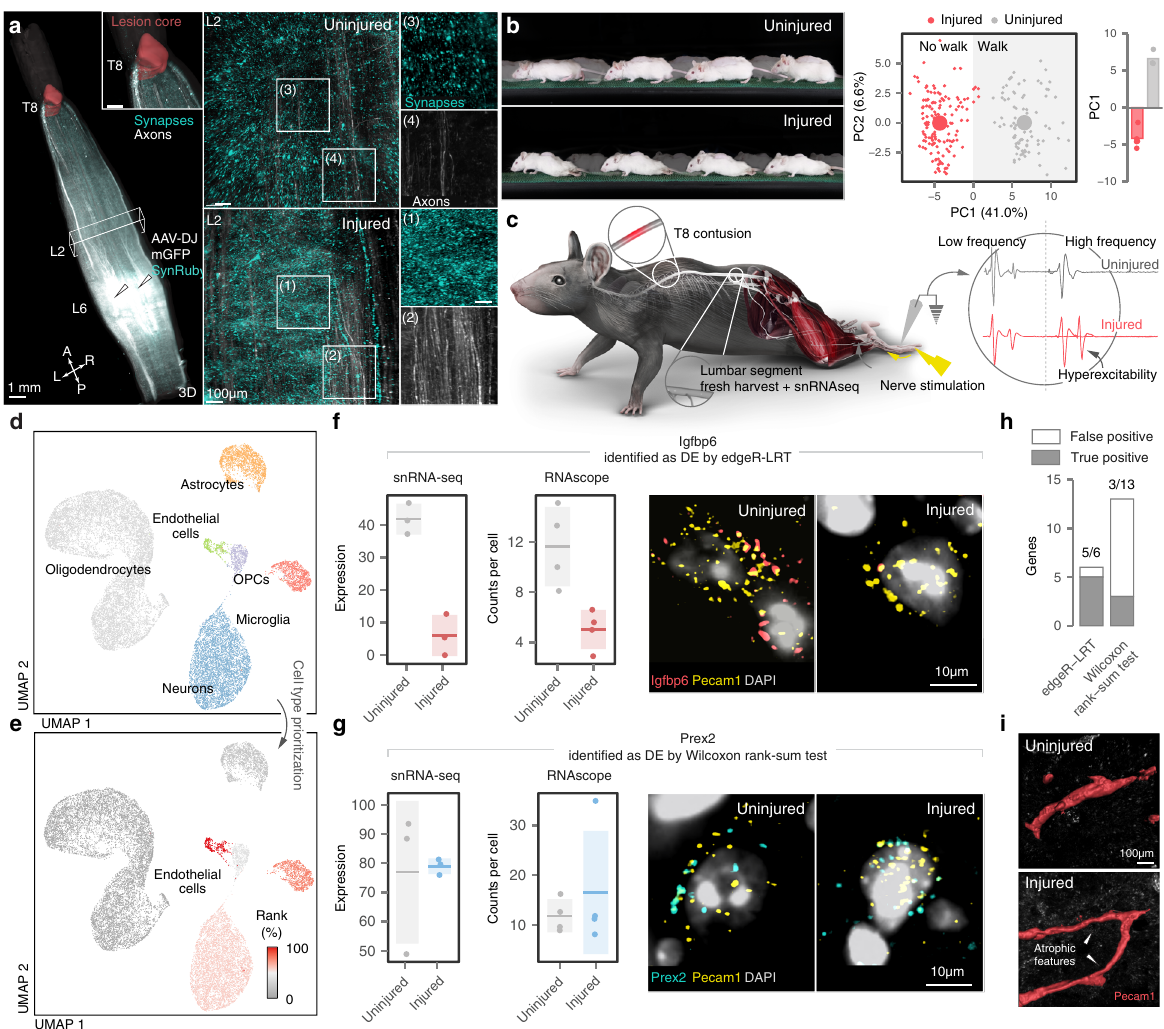
Fig. 5 True and false discoveries in the injured mouse spinal cord. a Synapses and projections of Vglut2 ON neurons in the mouse lumbar spinal cord before and after SCI. Experiments were repeated in n = 3 mice. b Top, chronophotography of mice before and after SCI. Bottom left, principal component analysis of gait parameters for each condition (small circles). Large circles show the average per group. Bottom right, bar plot showing the average scores on principal component 1 (PC1), which quantify the locomotor performance of injured and uninjured mice. c snRNA-seq experimental design. Inset demonstrates persistent amplitude at increasing frequency of the H-re fl ex in response to plantar stimulation, re fl ecting hyperexcitability. d Uniform manifold approximation and projection (UMAP) visualization of 19,237 nuclei, revealing the major cell types of the mouse lumbar spinal cord. e UMAP visualization colored by the AUC of cell type prioritizations, as calculated by Augur 27 . Endothelial cells are highlighted as the cell type with the highest AUC. f Pseudobulk expression levels in lumbar spinal cord endothelial cells by snRNA-seq (in counts per 10,000), left, and mean counts per Pecam1 ON cell by RNA-scope, center, for Igfbp6 , a gene identi fi ed as DE only by edgeR-LRT. Horizontal line and shaded area show the mean and standard deviation, respectively. Right, colocalization of Igfbp6 with the endothelial marker gene Pecam1 in RNAscope in situ hybridizations from injured and uninjured mouse spinal cords. g As in f , but for Prex2 , a gene identi fi ed as DE only by the Wilcoxon rank-sum test. h Summary of in vivo screen results. Filled bars represent genes validated by RNAscope. i , Immunohistochemistry reveals Pecam1 ON cells with atrophic features after SCI. Experiments were repeated in n = 3 mice. Source data are provided as a Source Data fi